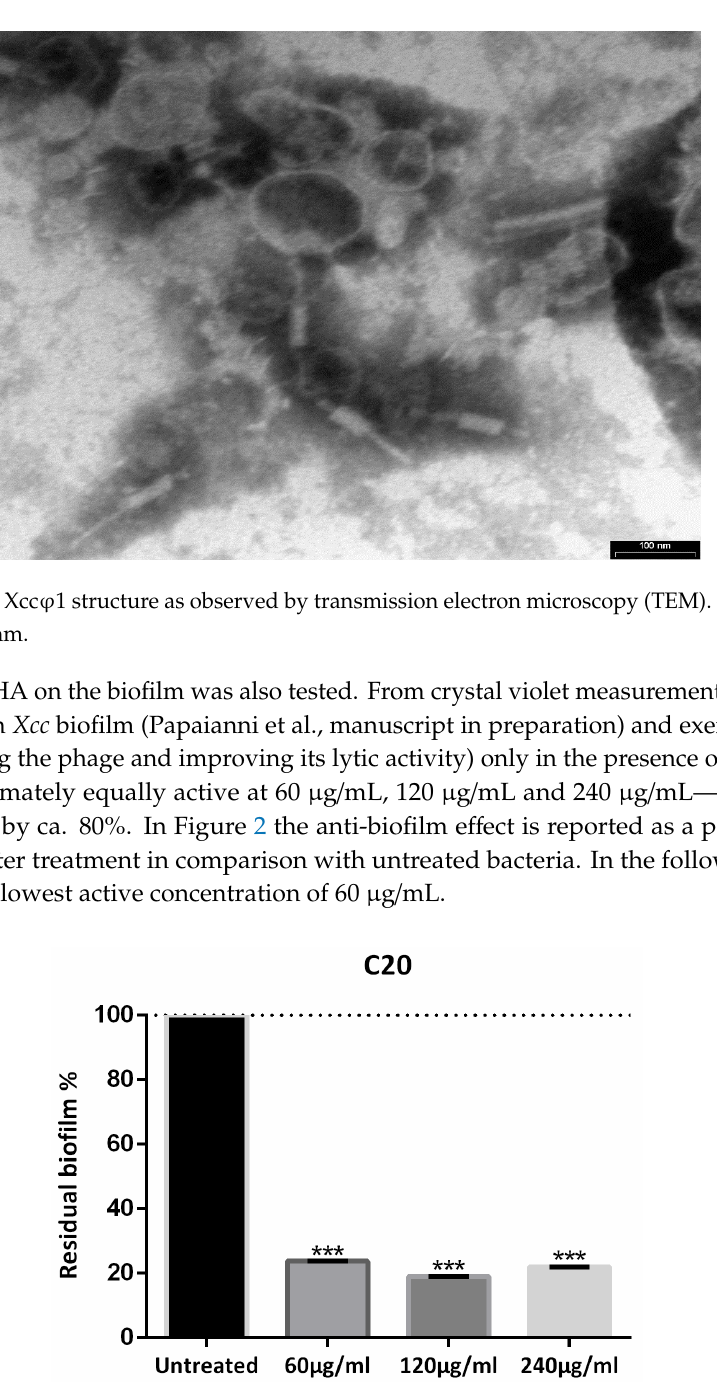
Figure 2. Eicosanoic acid (C20:0) activity on Xcc biofilm formation. Data are expressed as percent of residual biofilm. Each value indicates mean ± SD of three independent experiments. The t test was used to compare the absorbance of treated and untreated samples. *** p < 0.001.